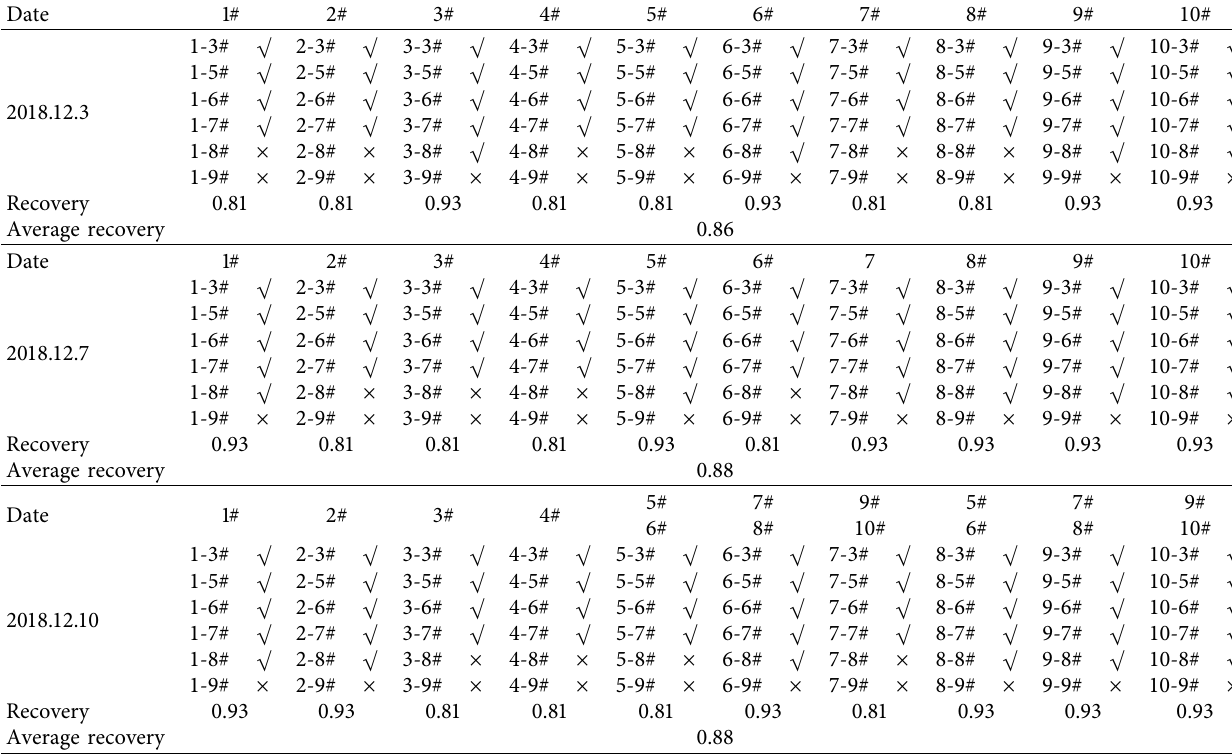
Table 6: Monitoring data of top coal recovery under the condition of one cutting and one caving with single-interval coal caving (“ √ ” means the monitoring point has been recovered, “ × ” means the monitoring point has not been recovered).